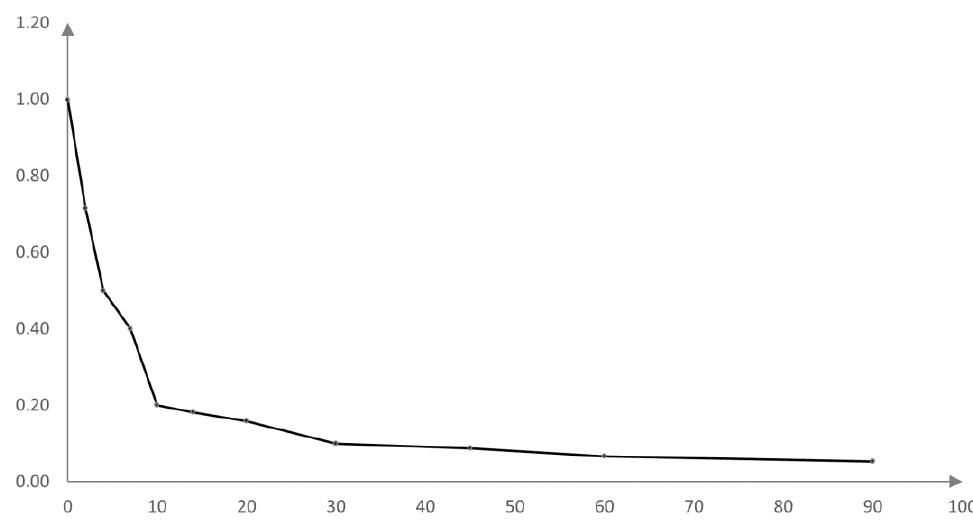
Figure 3. Discount function obtained from interview collection.